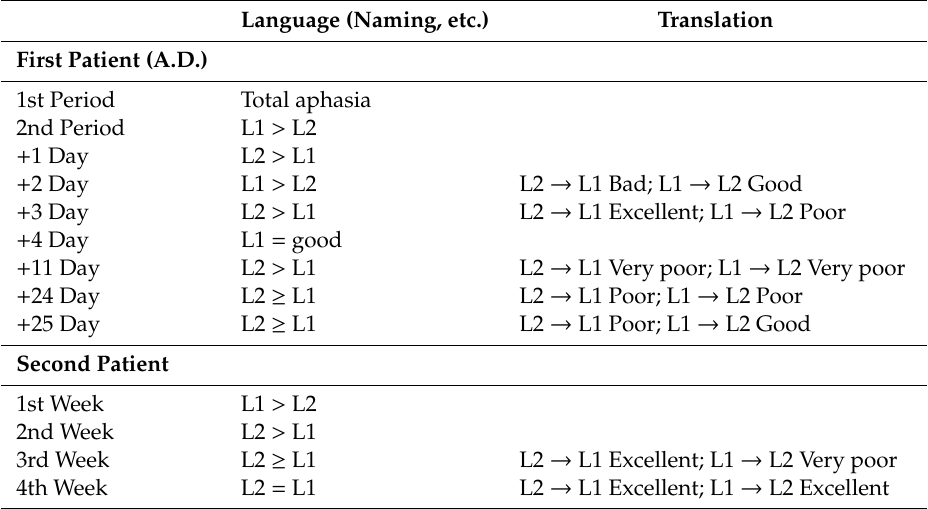
Table 2. (Alternate antagonism and Paradoxical translation) The alternate antagonism and paradoxical translation recovery patterns seen in two bilingual aphasic subjects; adapted from [10]. Language (Naming, etc.) Translation First Patient